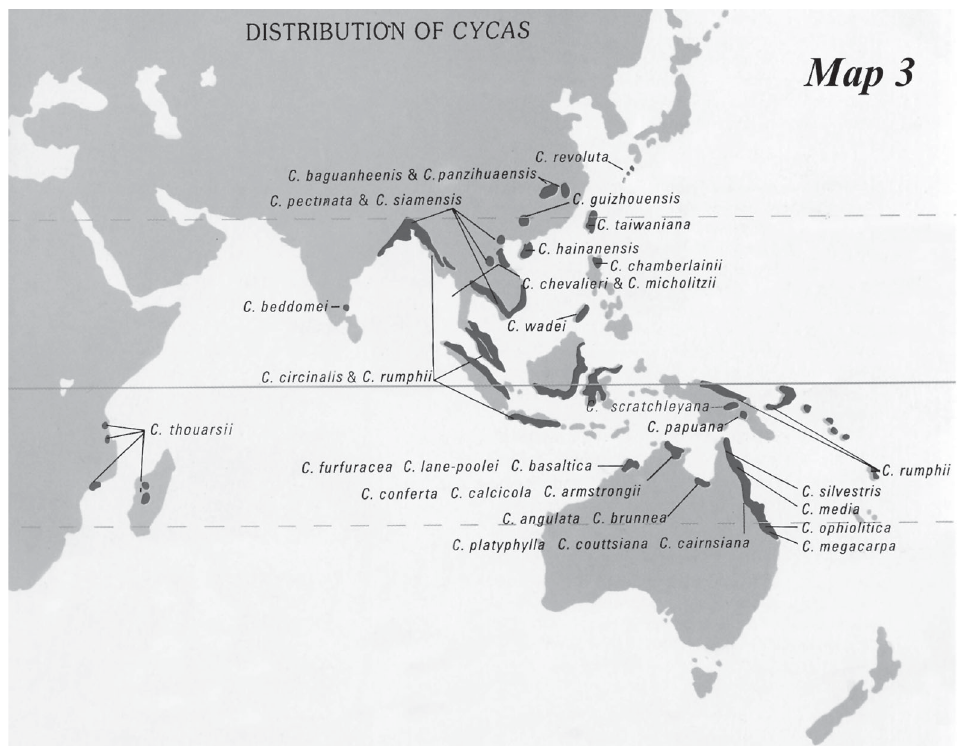
Figure 3. Cycas revoluta from Southeast Asia and Southern Japan. Reproduced from Ref. 36, with permission.